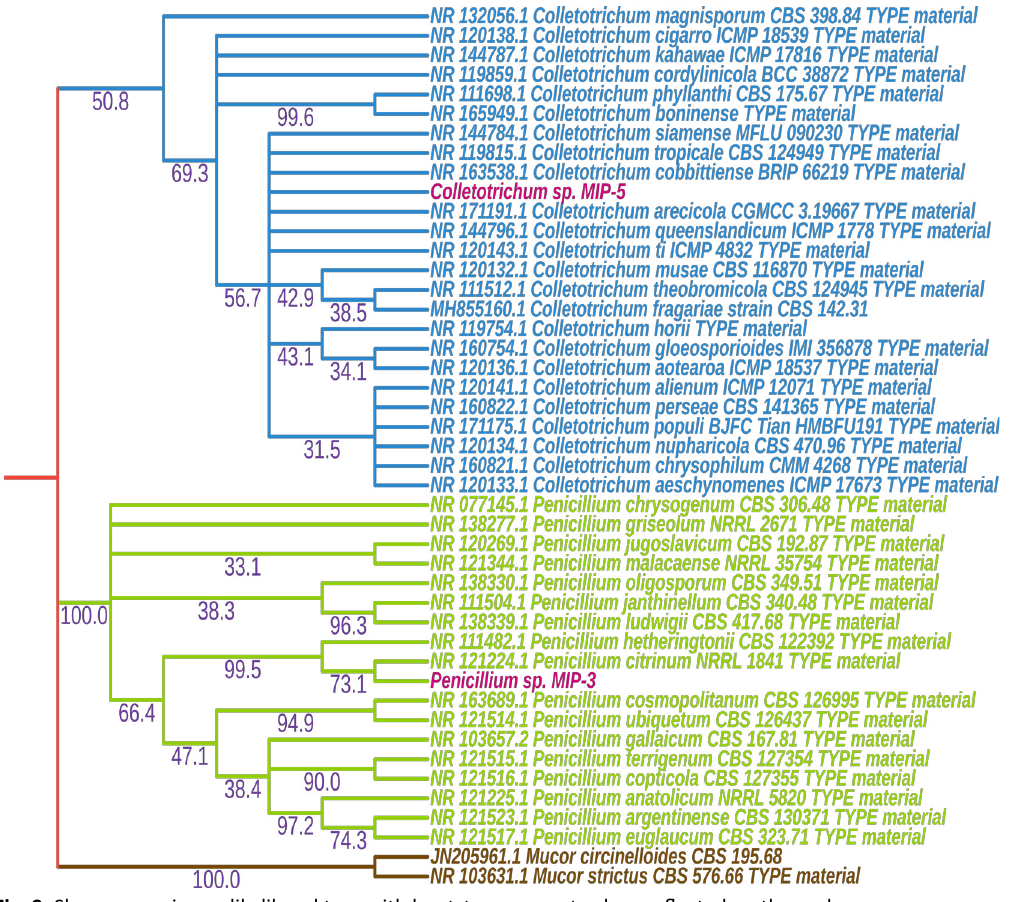
Fig. 9. Shows a maximum likelihood tree with bootstrap support values reflected on the nodes.